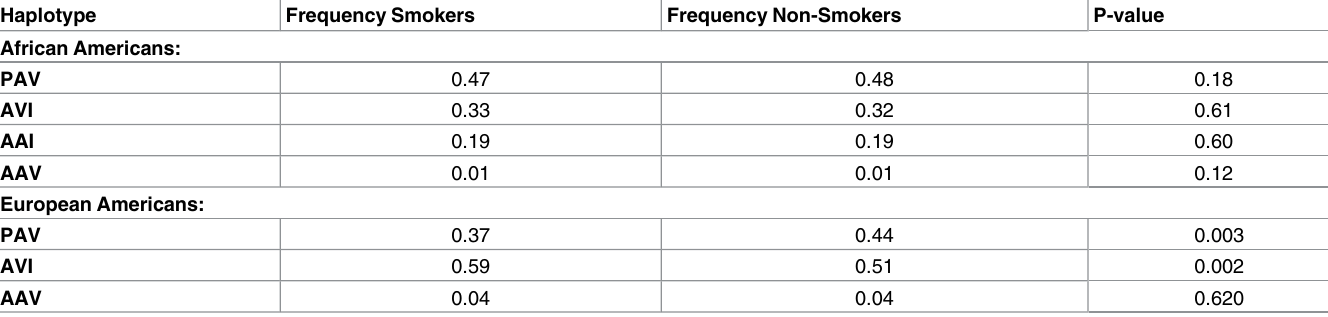
Table 2. Distribution of TAS2R38 haplotypes between smokers and non-smokers in the DHS population.